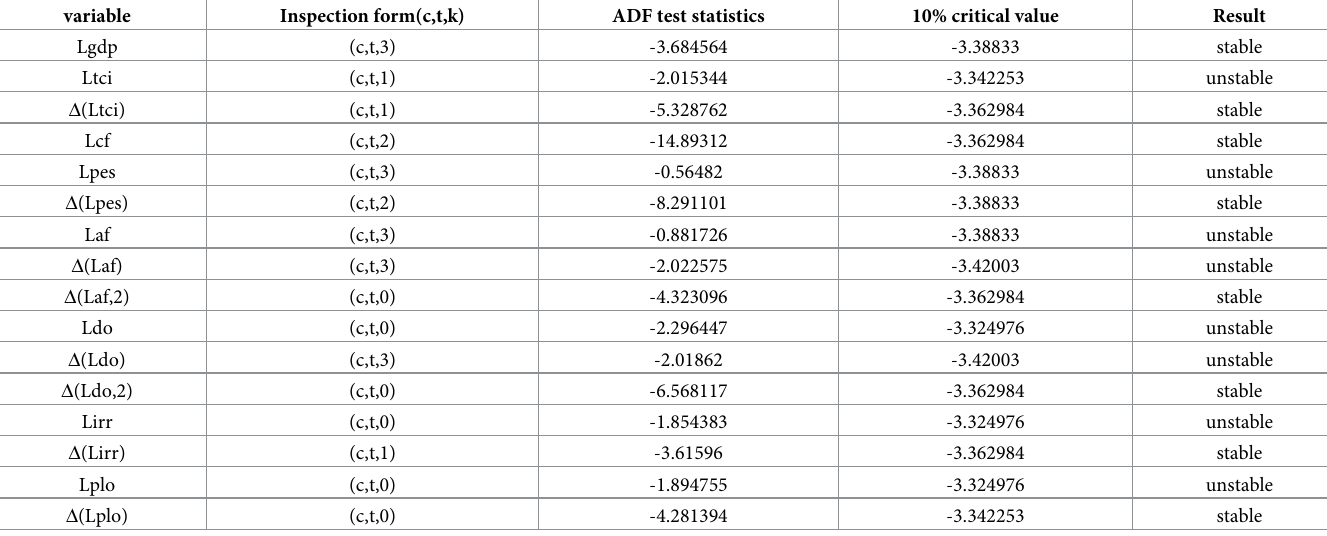
Table 4. ADF unit root test results of agricultural carbon emission intensity and economic growth variables.